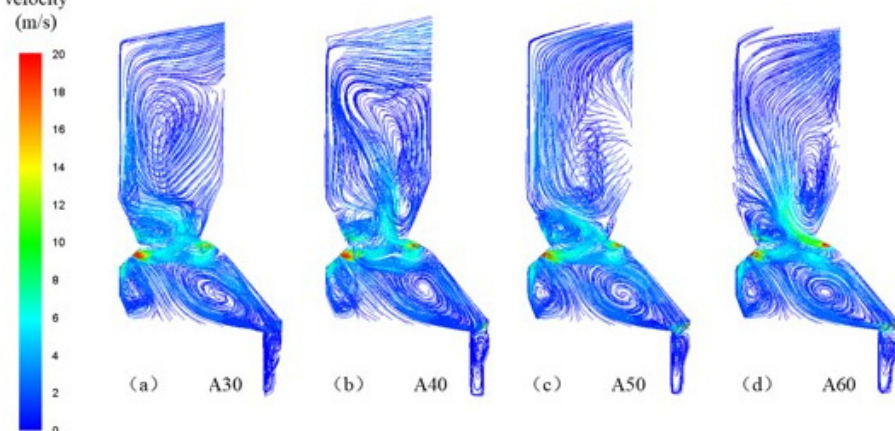
Figure 5. Flow line distribution in furnace of